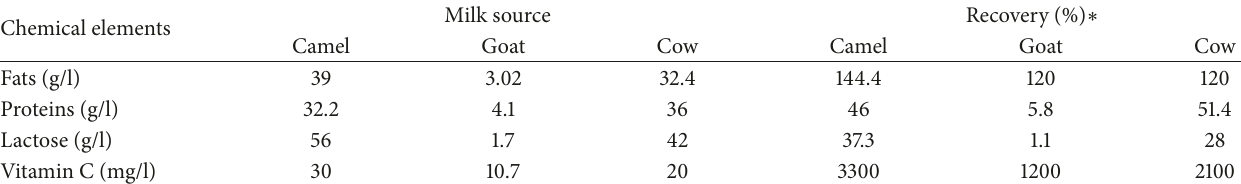
Table 3: Physicochemical and biochemical characteristics of camel milk from North Africa and East. Parameters Ma1 Ma2 Ma3 Ma4 Alg1 Acidity ( ∘ D) 13 Density (g/l) 1.030 fats (g/l) 34.9 Proteins (g/l) 32.6 Lactose (g/l) 47.8 Ashes (g/l) Vitamin